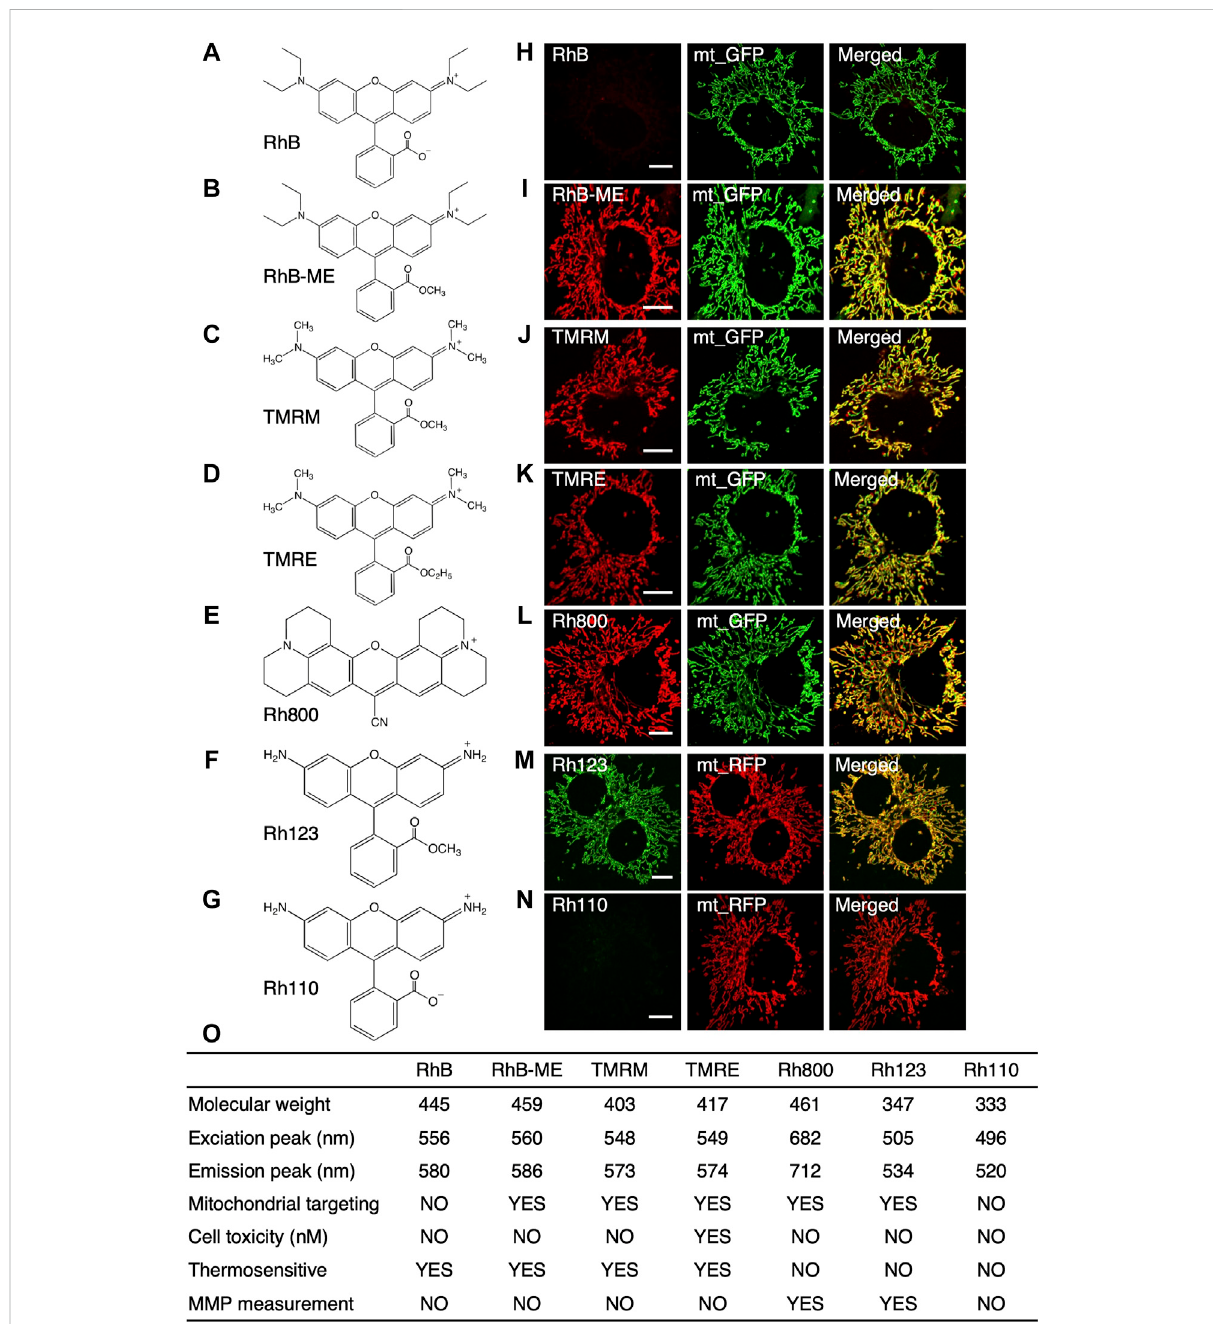
FIGURE 1 The summary for the characteristics of rhodamine dyes. (A – G) , the structure of rhodamine dyes. (A) , RhB (rhodamine B). (B) , RhB-ME (rhodamine B methyl ester). (C) , TMRM (tetra-methyl rhodamine methyl ester). (D) , TMRE (tetra-methyl rhodamine ethyl ester). (E) , Rh800 (rhodamine 800). (F) , Rh123 (rhodamine 123). (G) , Rh110 (rhodamine 110). (H – N) , Co-localization of rhodamine dyes with mt-GFP or mt-RFP in COS7 cells. RhB (H) and Rh110 (N) are unable to target in mitochondria, while RhB-ME (I) , TMRM (J) , TMRE (K) , Rh800 (L) and Rh123 (M) target mitochondria very well. (O) , the summary of the characteristics of rhodamine